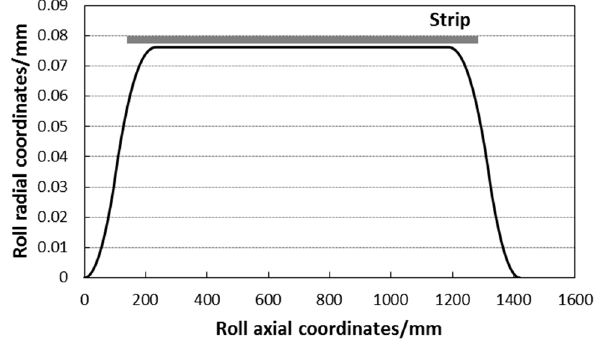
Figure 5. Work roll shape curve.